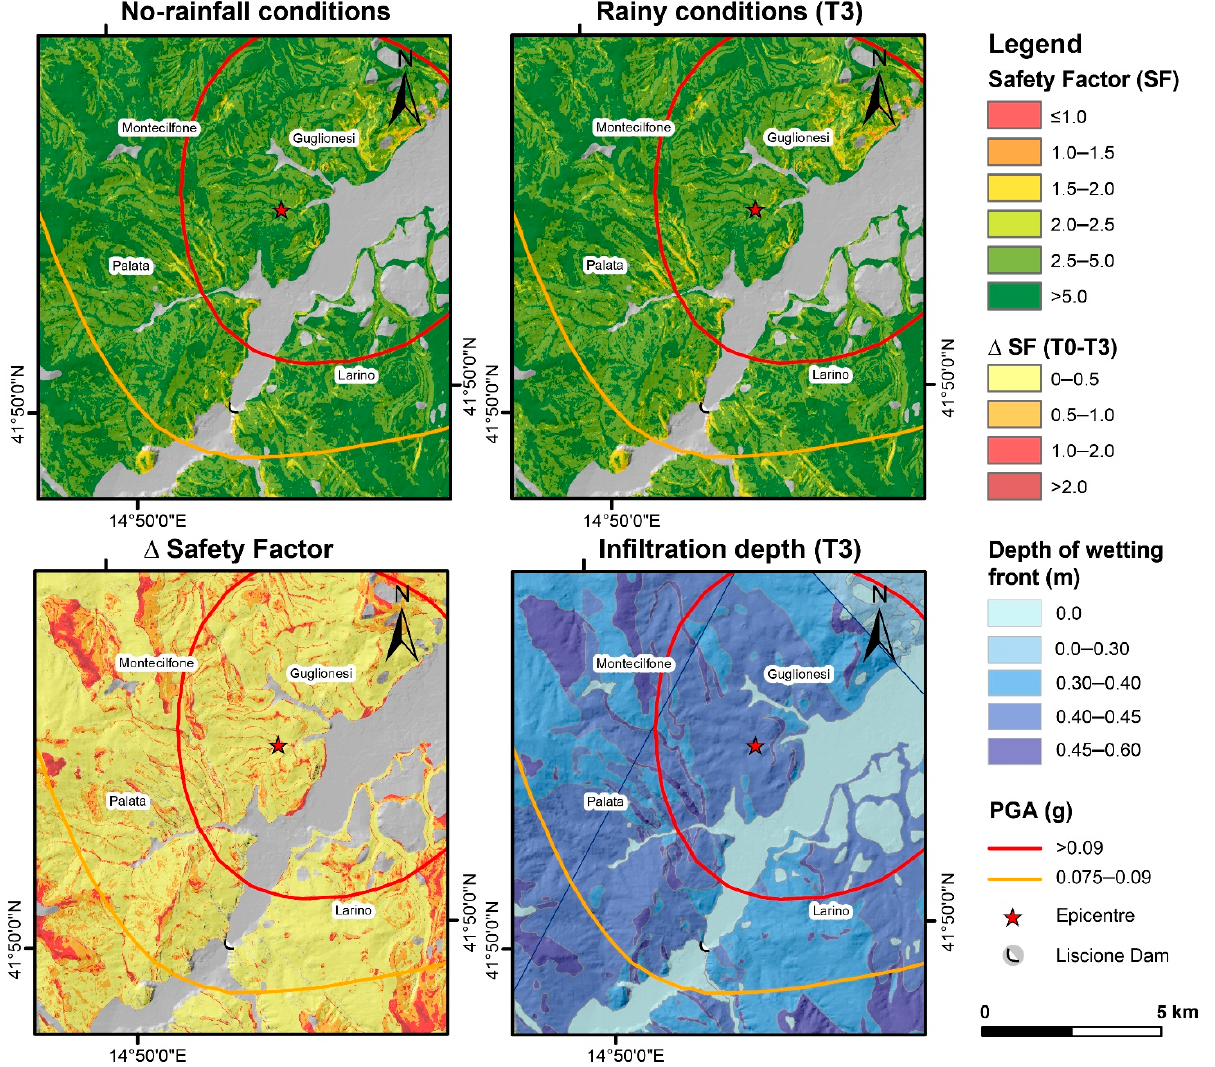
Figure 9. Maps showing: static SF at the maximum depth of soil covers considering absence of rainfall ( top-left ); static SF at the maximum depth of soil covers considering partially saturated conditions due to rainfall ( top-right ); difference between SF obtained by the two conditions ( bottom-left ); depth of infiltration level ( bottom-right ).